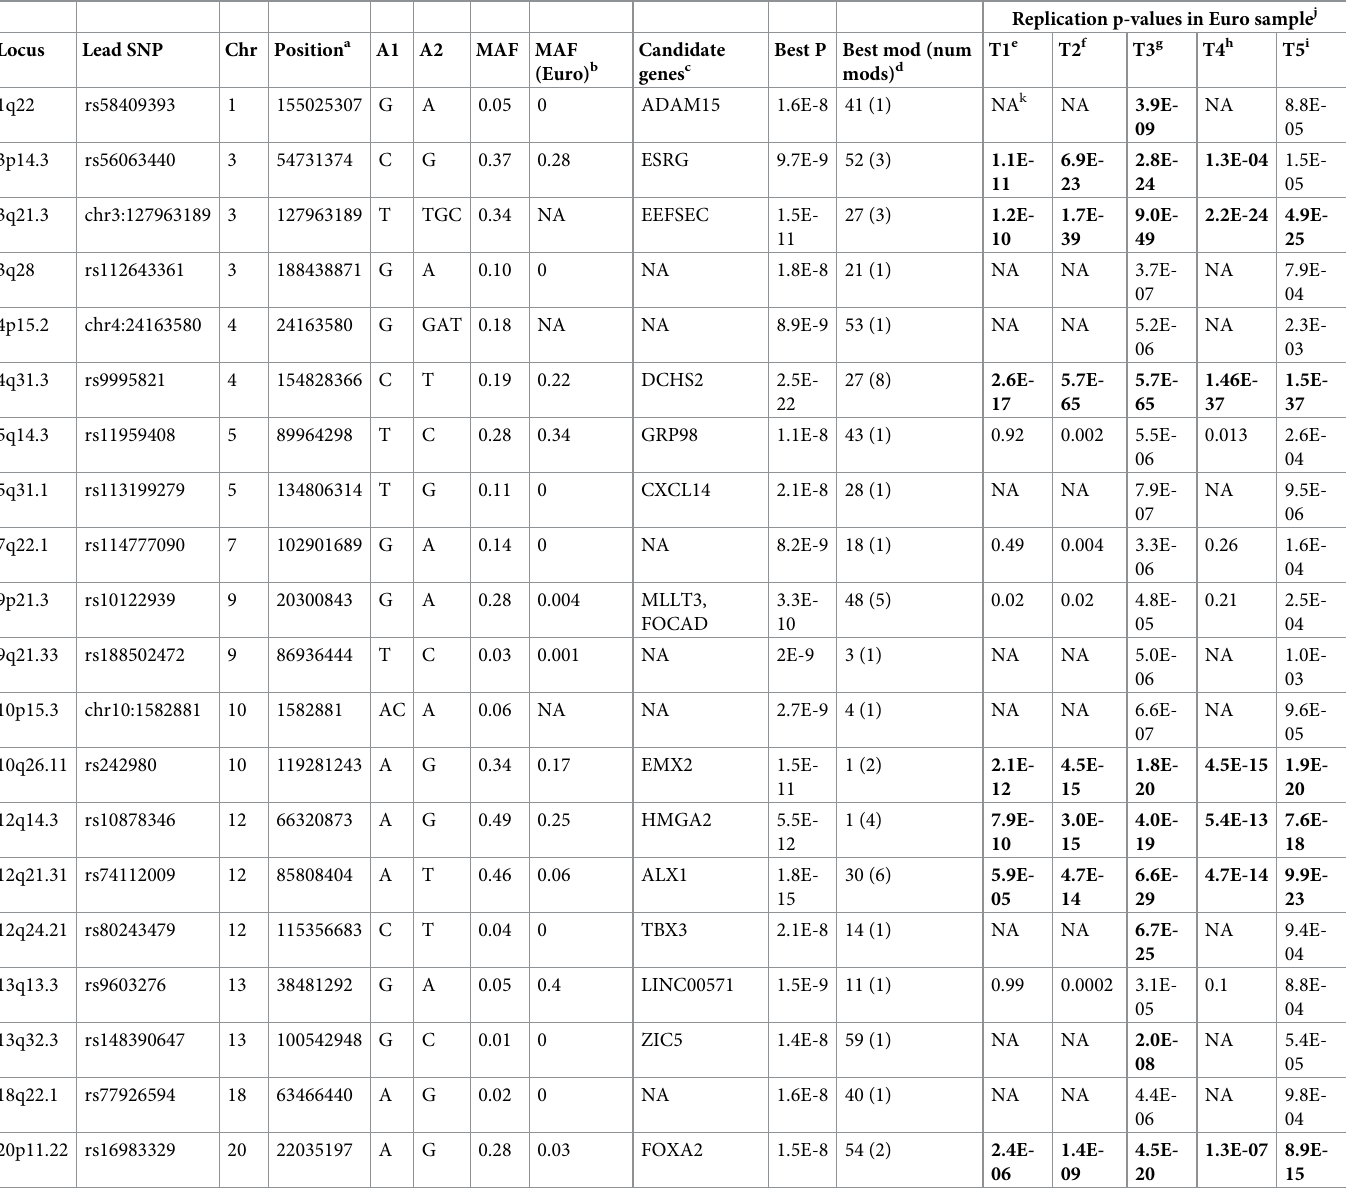
Table 1. Summary of 20 GWAS signals in